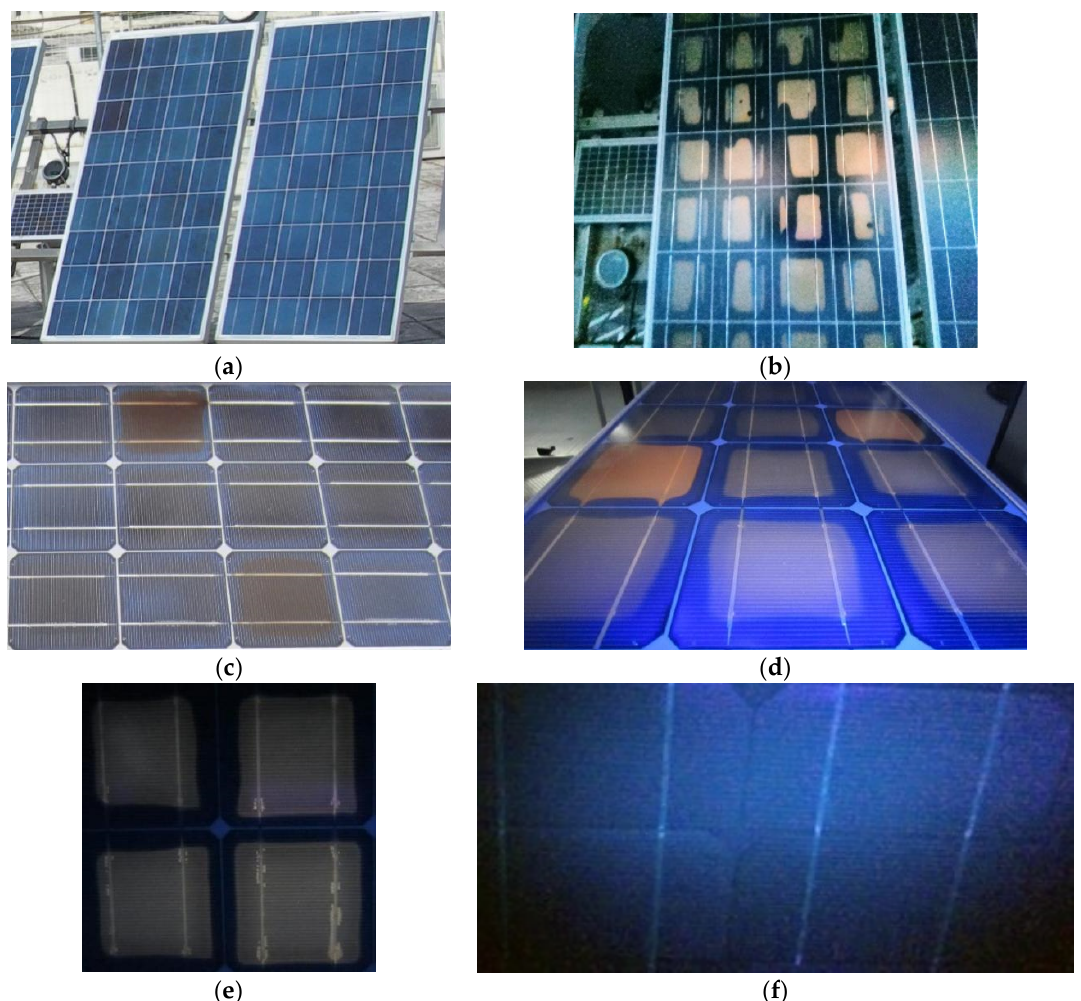
Figure 1. IR thermography of a pc-Si module captured at the backside of the module, showing a transient shadow falling diagonally on the two bottom cells, creating temporary T c patterns in the affected cells.